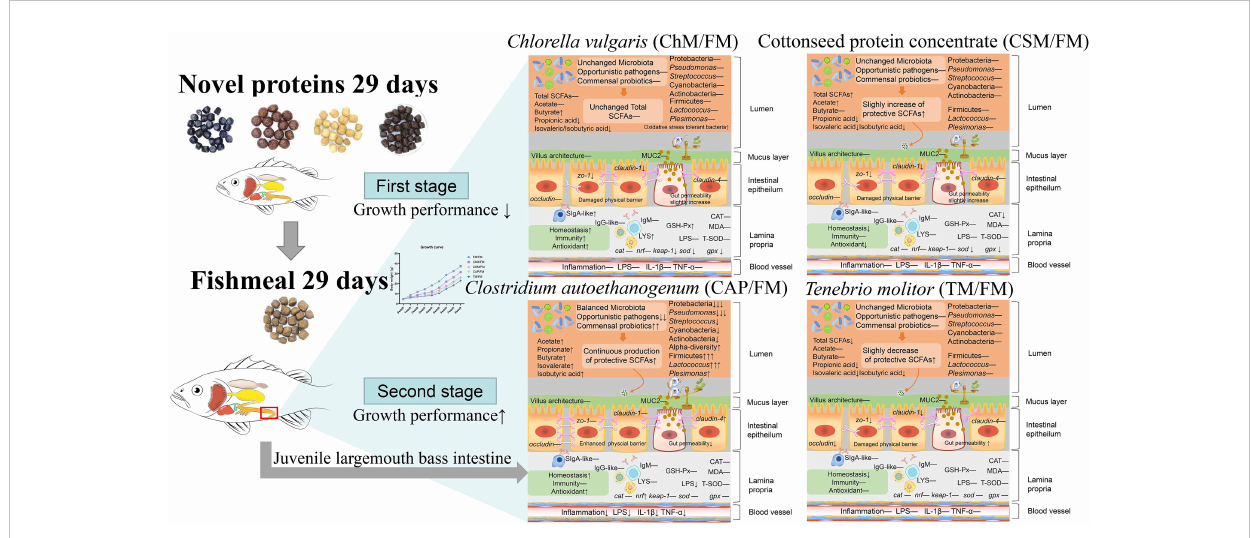
FIGURE 9 A schematic model showing the mechanism of the effects of novel protein diets on the intestinal health of juvenile largemouth bass under an alternate feeding